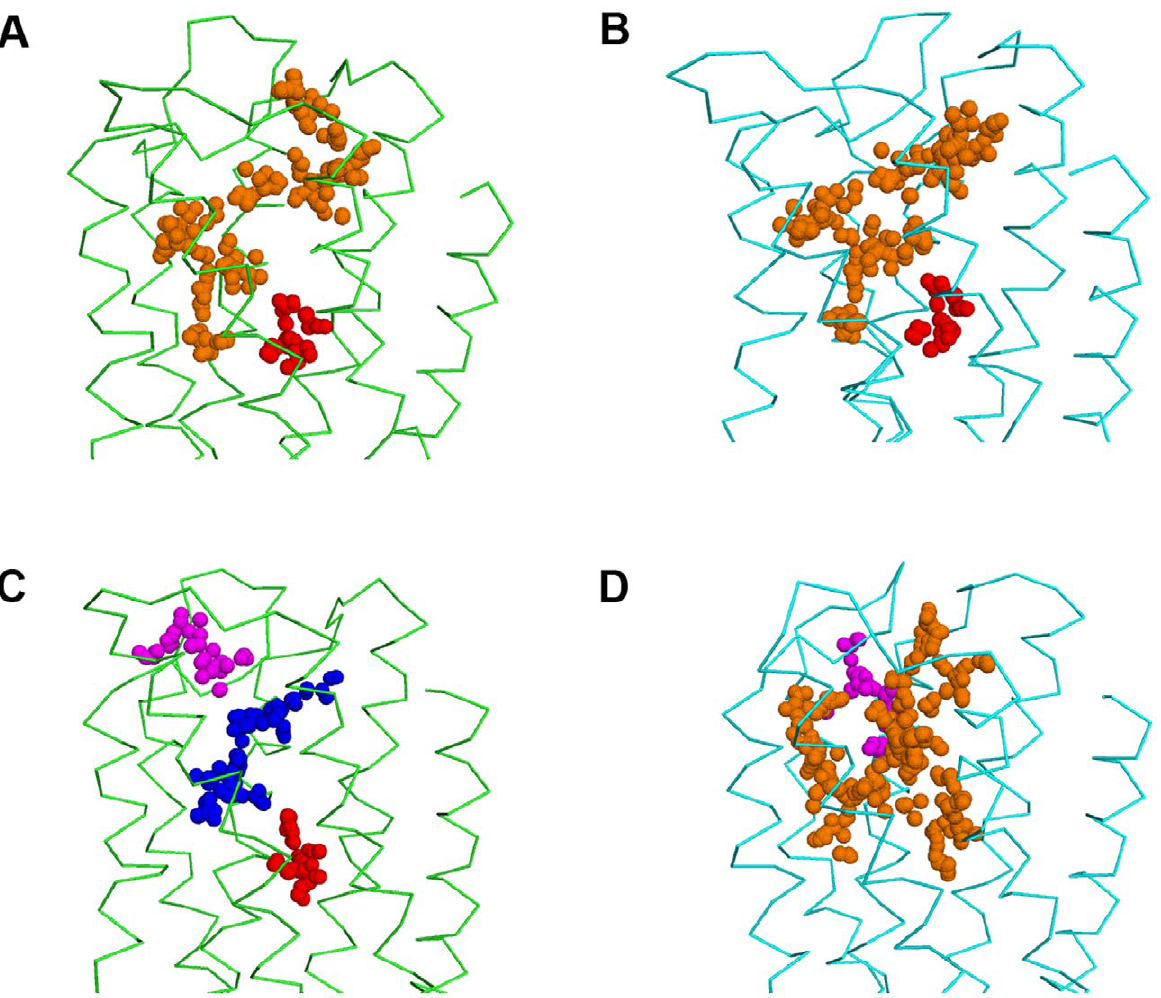
Figure 6. Evolution of binding pockets of hD 3 and hD 2L receptor after model refinement. Pockets generated by Fpocket server are represented as colored clusters of spheres. Left panels represent hD 3 (green ribbons) and right panels represent hD 2L (cyan ribbons), before (A, B) and after (C, D) MD simulations. The red circles target the orthosteric binding pocket whereas the black circles highlight the allosteric binding pocket.